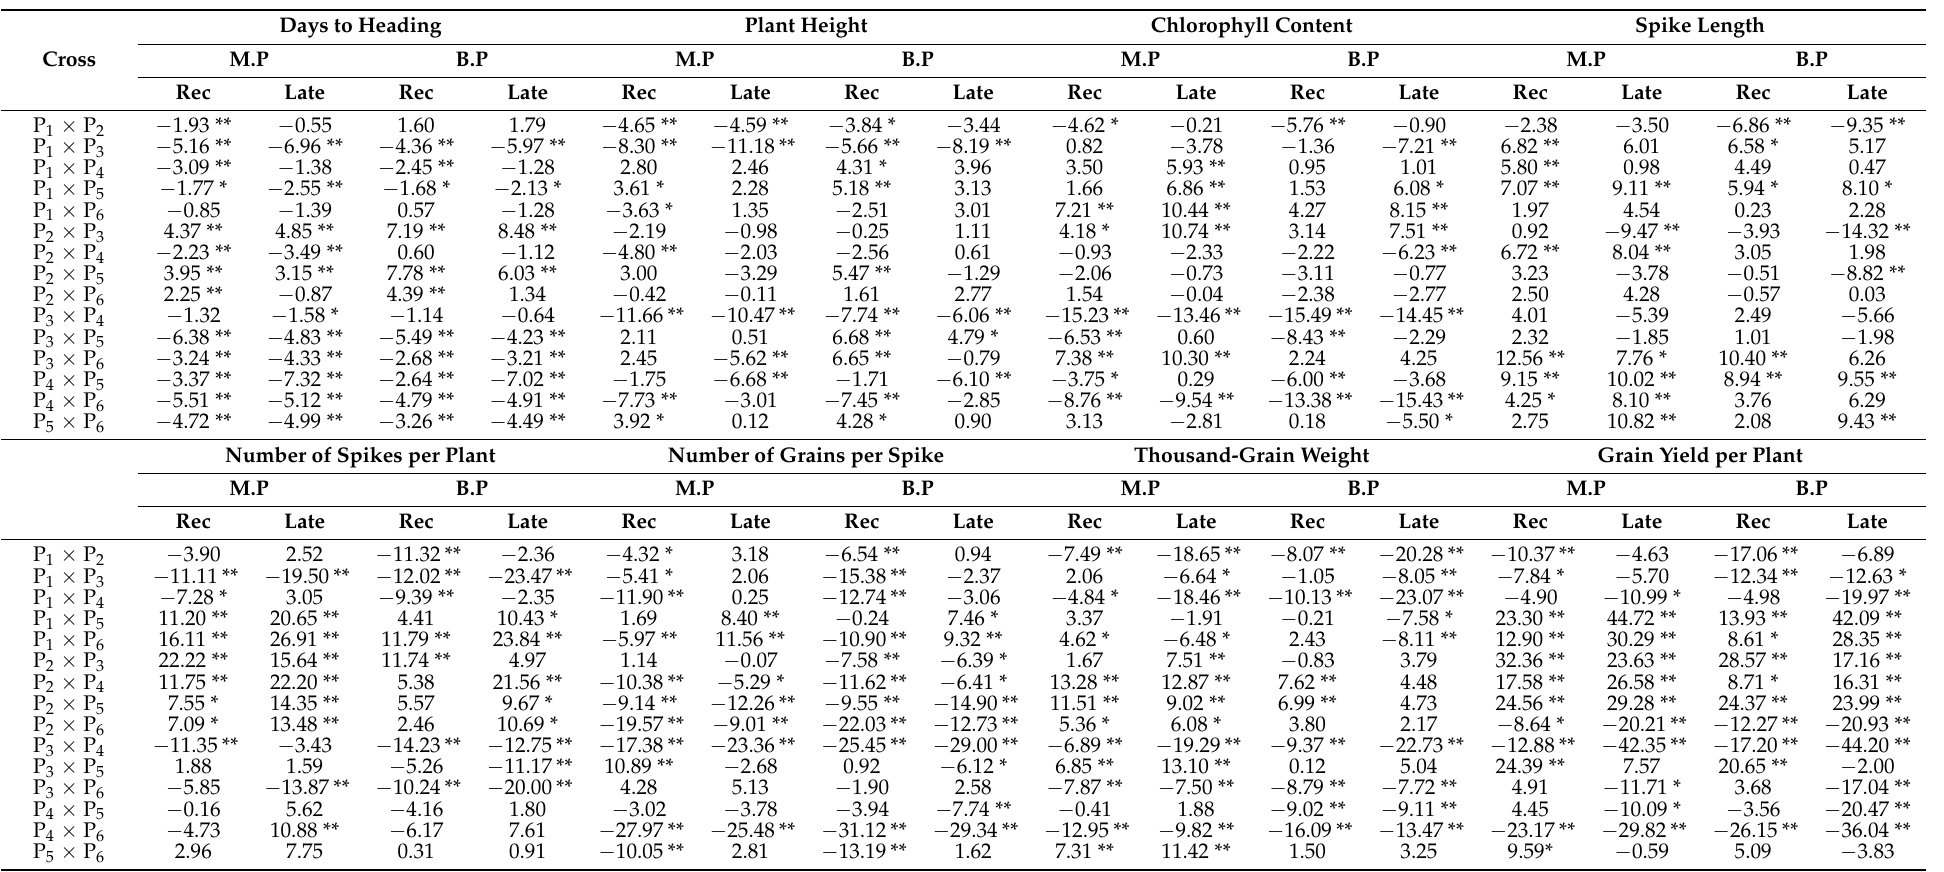
Table 4. Heterosis percentages relative to mid (MP) and better (BP) parent for all the evaluated traits under recommended and late sowing dates across the two locations. Days to Cross